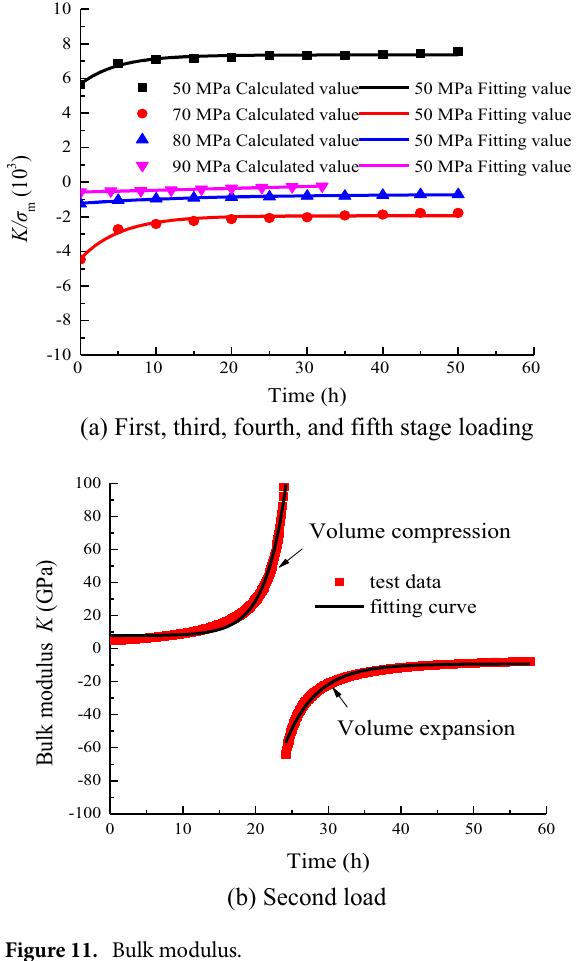
Figure 11. Bulk modulus.